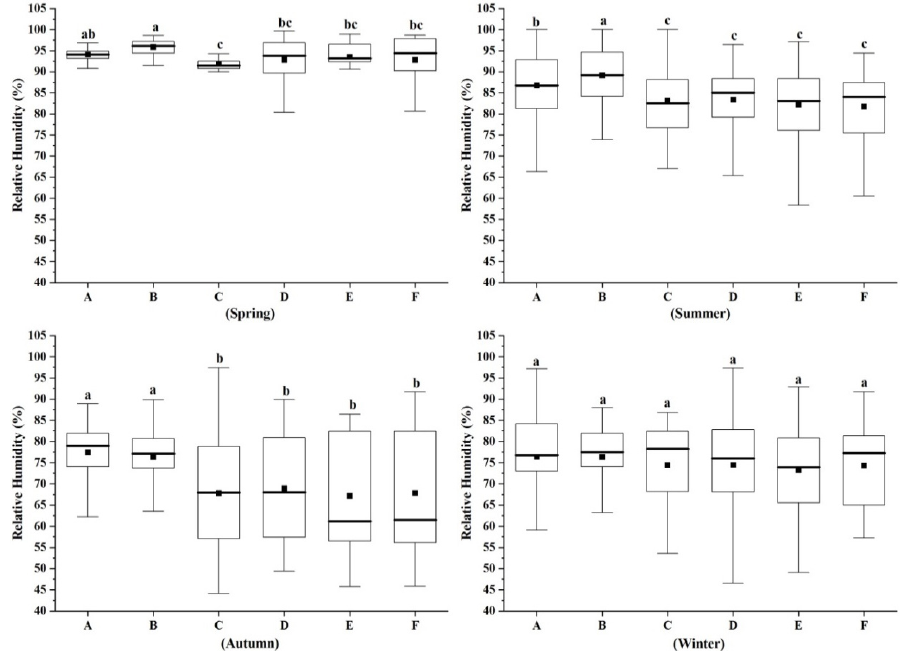
Figure 8. The relative humidity changes of different forest types in different seasons. A— Phyllostachys edulis forest; B—Subtropical evergreen broad-leaved forest; C—Forestless control group; D— Liquidambar formosana forest; E— Cunninghamia lanceolata forest; F—Coniferous and broad-leaved mixed forest. The different lowercase letters indicate significant difference among the stand types in the same time ( p <